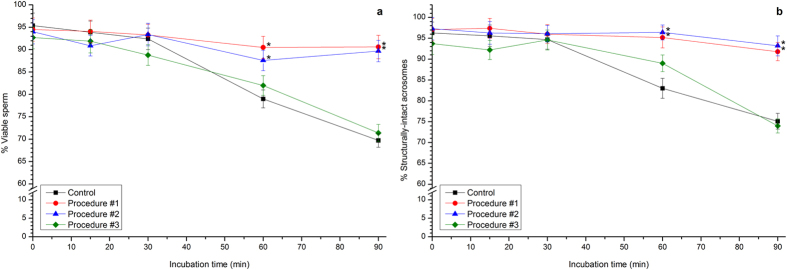
Percentages of viability and spermatozoa structurally-intact acrosomes of boar spermatozoa subjected to incubation at 37 °C for 90 min after photo-stimulation procedures.Boar sperm were subjected to separate photo-stimulation procedures and subsequent incubation at 37 °C as described in the Methods section. At the indicated times, aliquots were taken and percentages of viability (a) and structurally intact acrosomes (b) were determined. Results are shown as mean ± SEM. for 12 separate experiments. Asterisks indicate significant (P < 0.05) differences when compared with the respective Control value at the same time point.